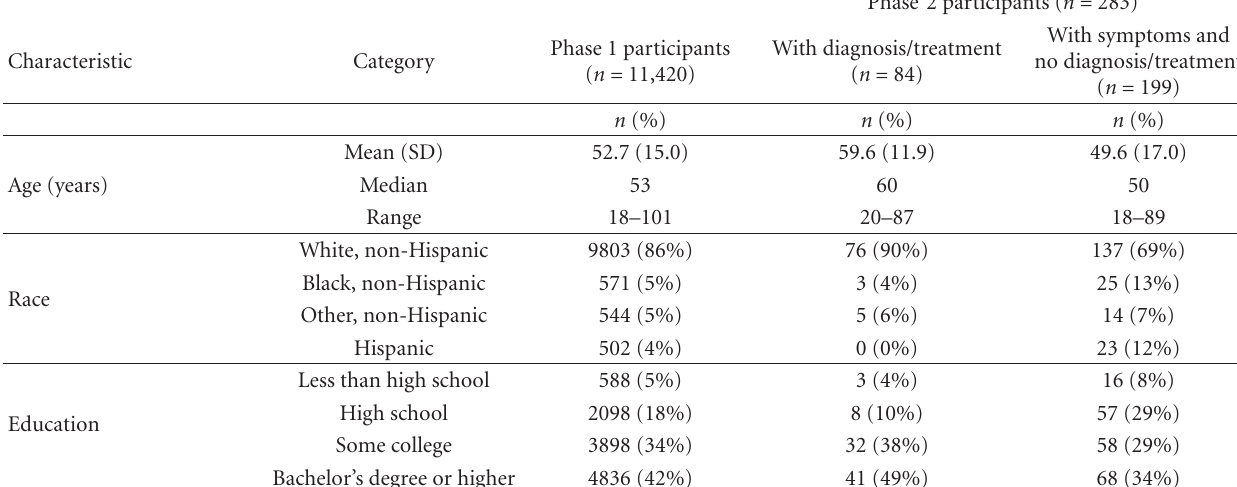
Table 2: Demographic characteristics of Phases 1 and 2 male